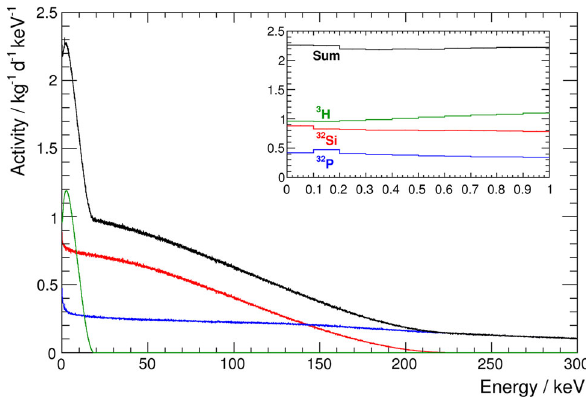
Fig. 10 Simulation of the energy deposition in a silicon sensor from radioactive 32 Si / 32 P decays with a given activity of 80kg − 1 day − 1 and 3 H decays with a given activity of 11 . 57kg − 1 day − 1 . The histograms show the energy depositions from: the 32 Si decays (red), the subsequent 32 Pdecay(blue),the 3 Hdecay(green),andthesumofalldecays(black). The inset zooms to the flat part of the spectrum below 1keV. Statistical uncertainties are comparable to the line